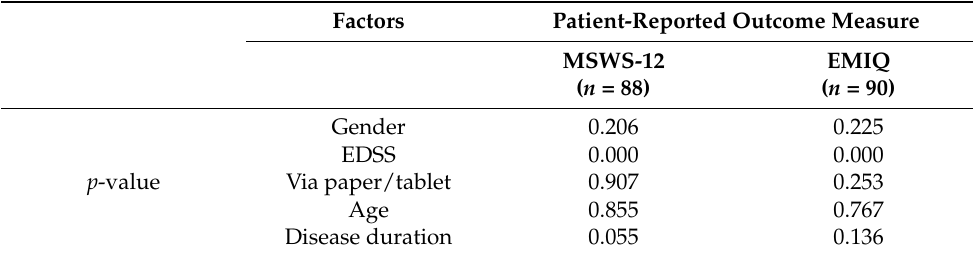
Table 7. Model effects for patient-reported outcome measures and demographic or clinical data.